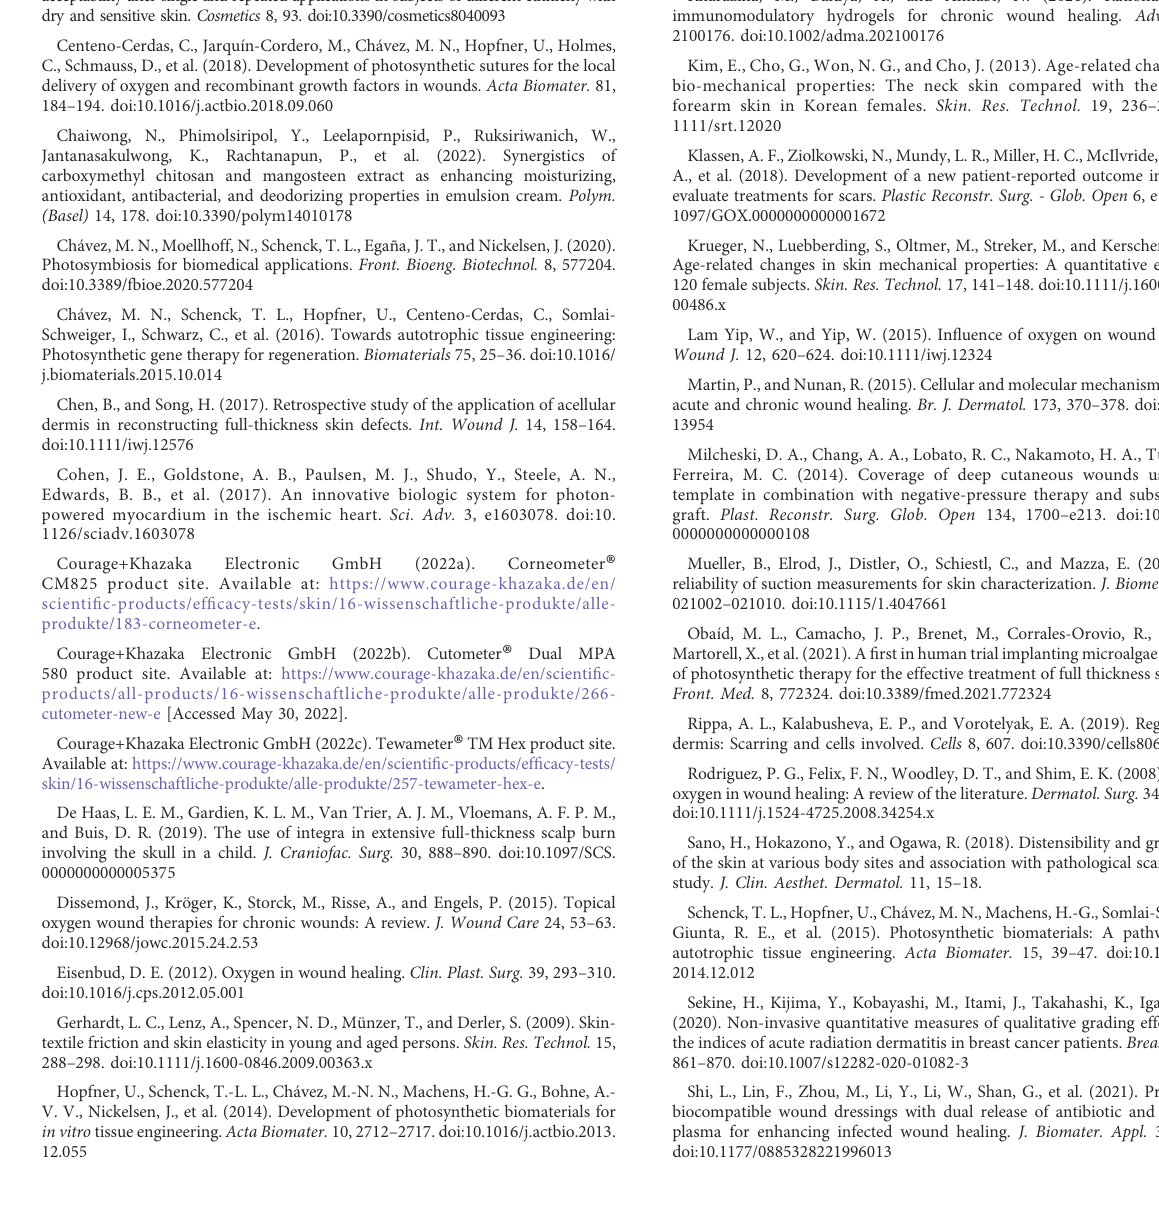
SUPPLEMENTARY FIGURE S2 Post-surgical self-evaluation questionnaire. The patient was evaluated daily for 10 days after the photosynthetic scaffold implantation surgery intermsoftheself-perception score of fi veparameters: perceivedpain (A) , ranging from 0 to 10, itching (B) , ranging from 0 to 3, burning